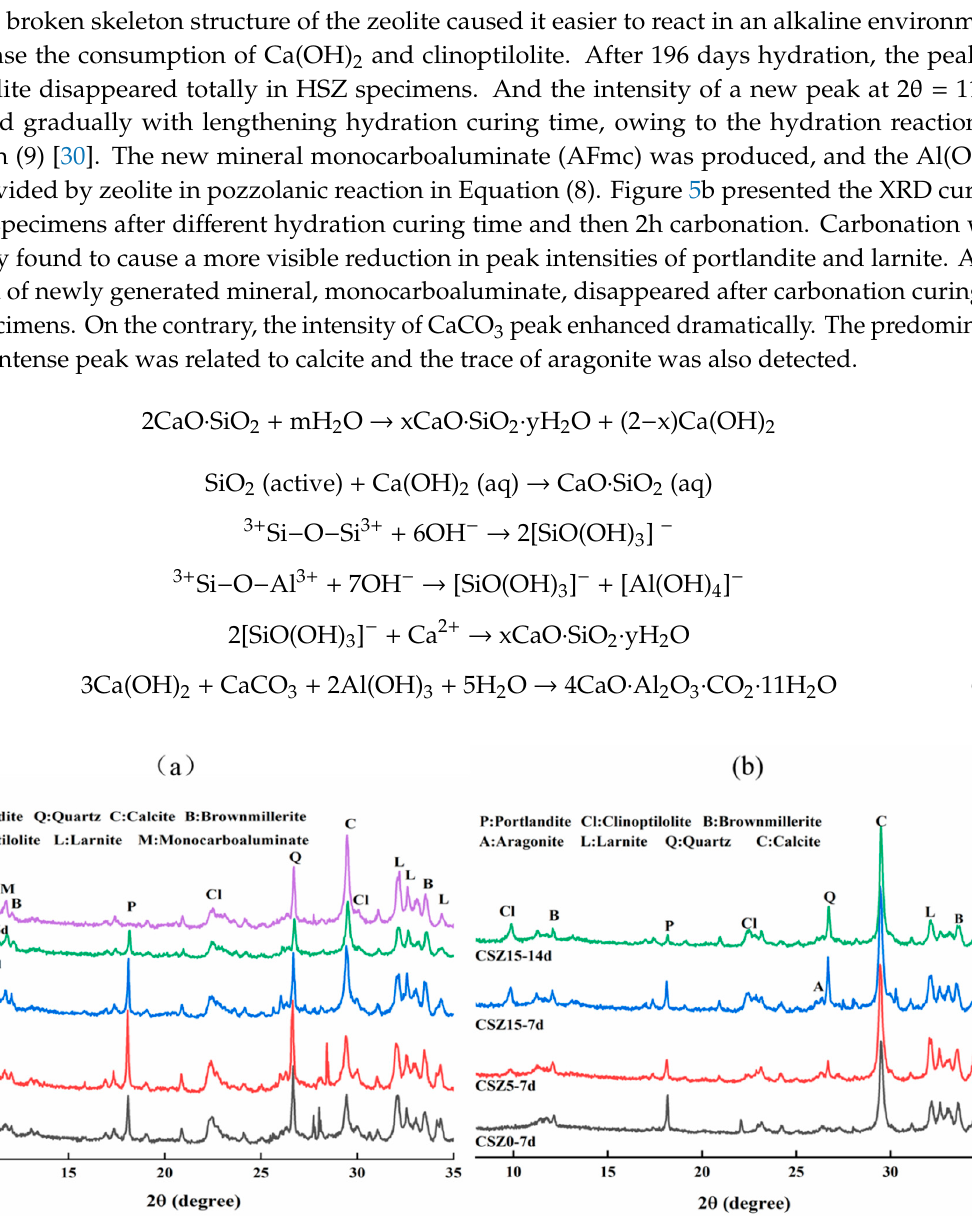
Figure 5. X-ray di ff raction (XRD) curves of SZ specimens after the “H” or “C” process. ( a ) evolution of minerals peak intensity in SZ15 after the “H” process; ( b ) evolution of minerals peak intensity in SZ specimens after the “C” process. (H: hydration at di ff erent times; C: hydration at di ff erent time and subsequent 2 h